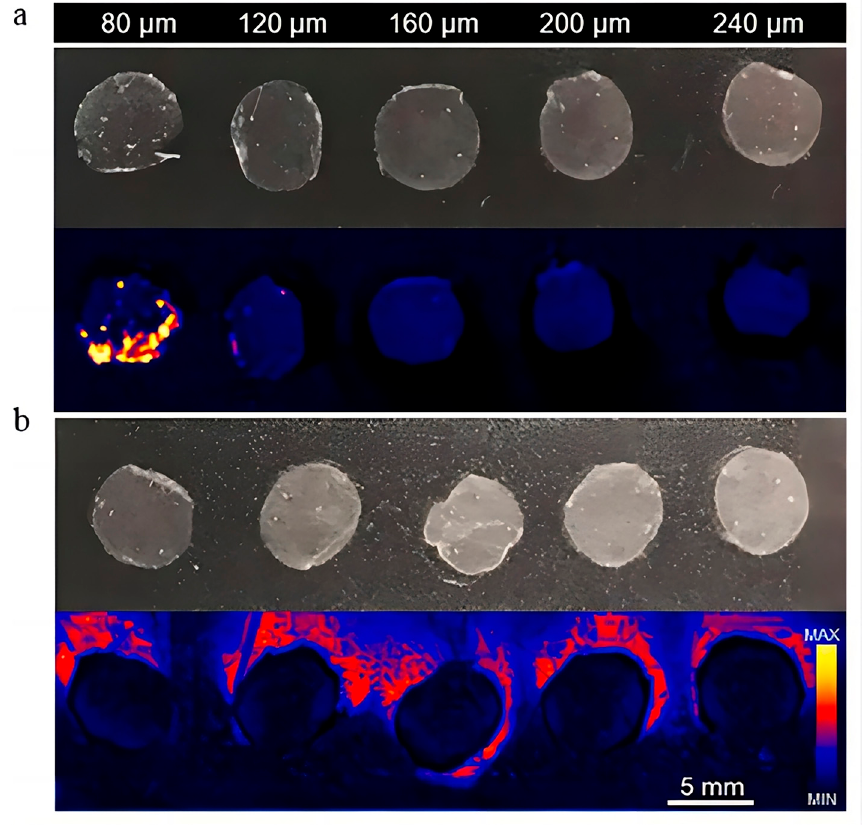
Figure 11. Optical images and DESI mass spectrometry images of horizontal skin sections (40 µm) showing TPGS ( m / z 772.4706) deposition from ( a ) a 4% TPGS micelle solution and ( b ) untreated skin sample [85]. Copyright 2021 Elsevier.